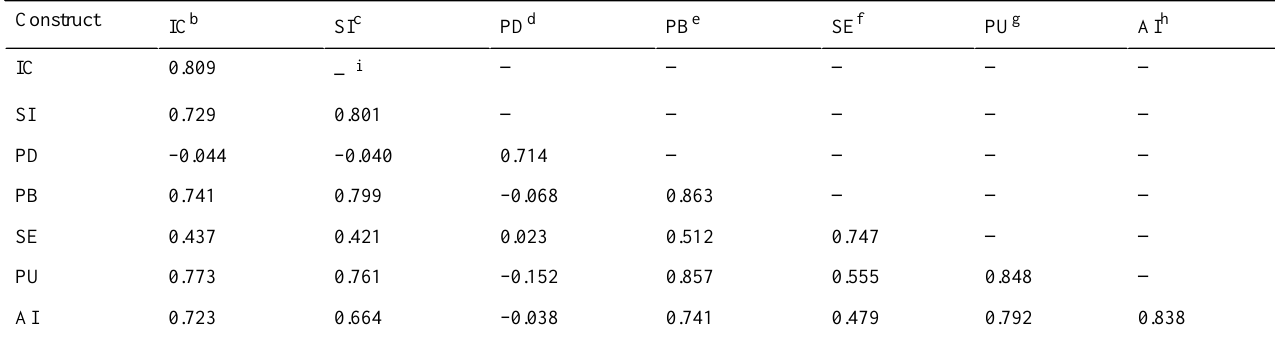
Table 4. Correlation analysis among constructs to determine discriminant validity. a